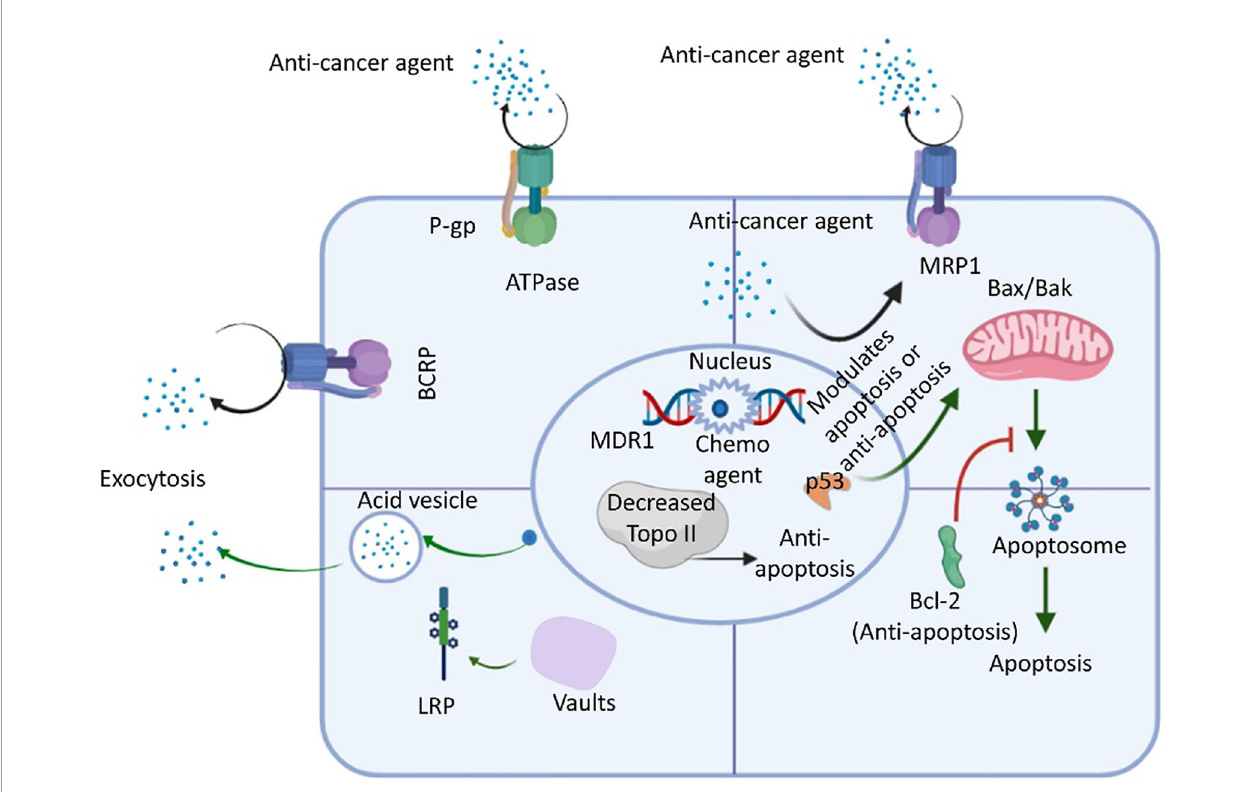
FIGURE 3 | An overview of drug resistance mechanisms in cancer cells using ABC transporter, LRP, Bcl-2 , and Topo ll . The ATP-binding cassette (ABC) transporter is an ATP-activated transporter. In general chemotherapy, cells express ABC transporters to remove foreign molecules (e.g., xenobiotics, anticancer agents, etc.) from the intracellular environment. P-glycoprotein (P-gp), multidrug-resistant protein 1 (MRP-1), and breast cancer resistance protein (BCRP) are the predominant members of the ABC transporter family. Lung resistance protein (LRP) resides in vaults (cytoplasmic) and contributes to the exocytosis of foreign molecules, including anticancer drugs. Research also revealed that the upregulation of bcl-2 (an anti-apoptotic factor acted upon by anticancer agents that activate the normal apoptosis process), p53 loss-of-function of p53, and the downregulation of topoisomerase II ( Topo-II ) also decrease cell apoptosis to increase the resistance of cancer cells to anticancer drugs